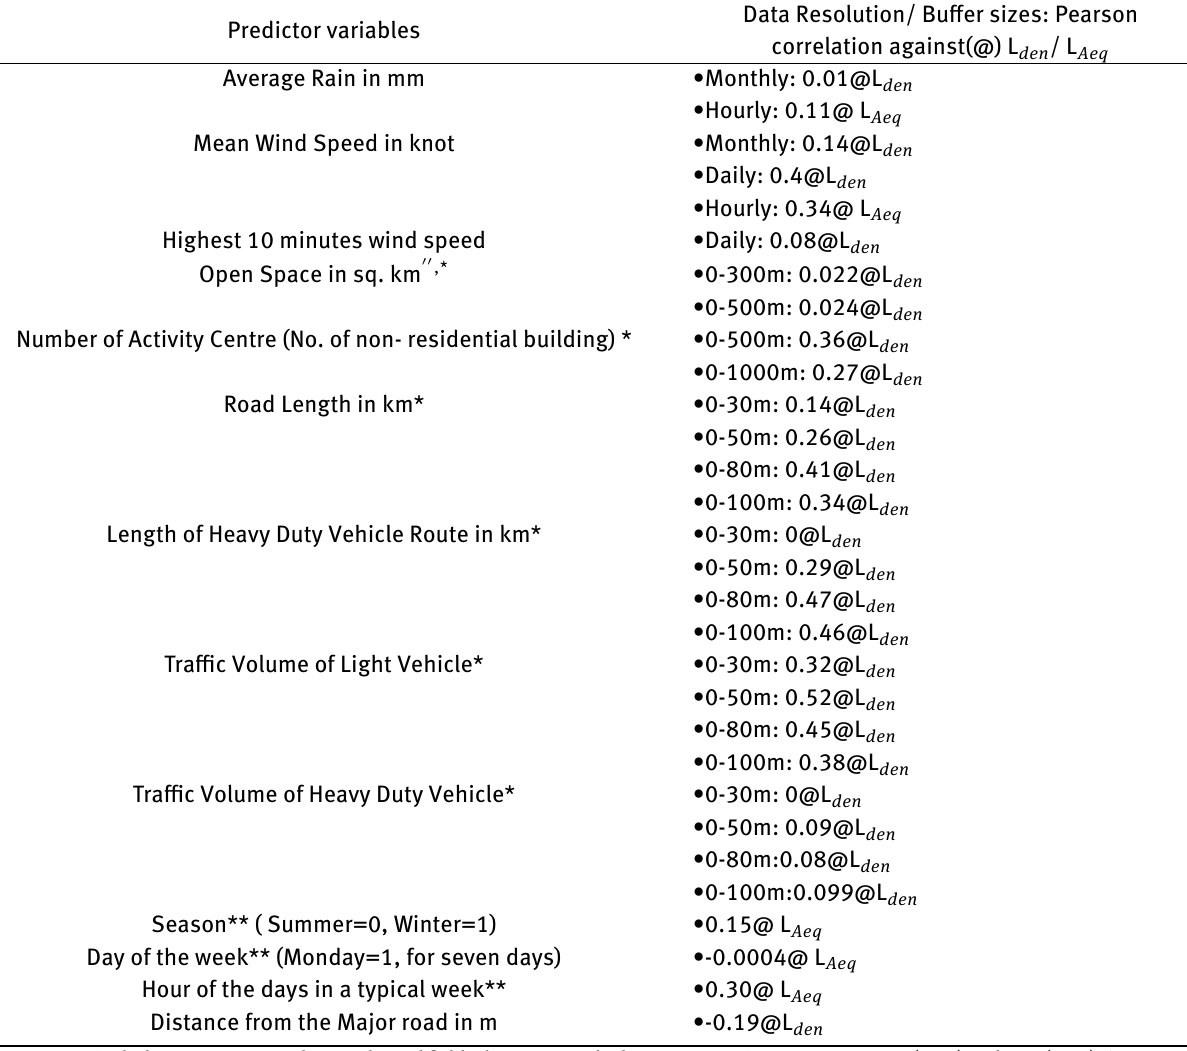
Supplementary Table 4: List of predictors assessed for the model